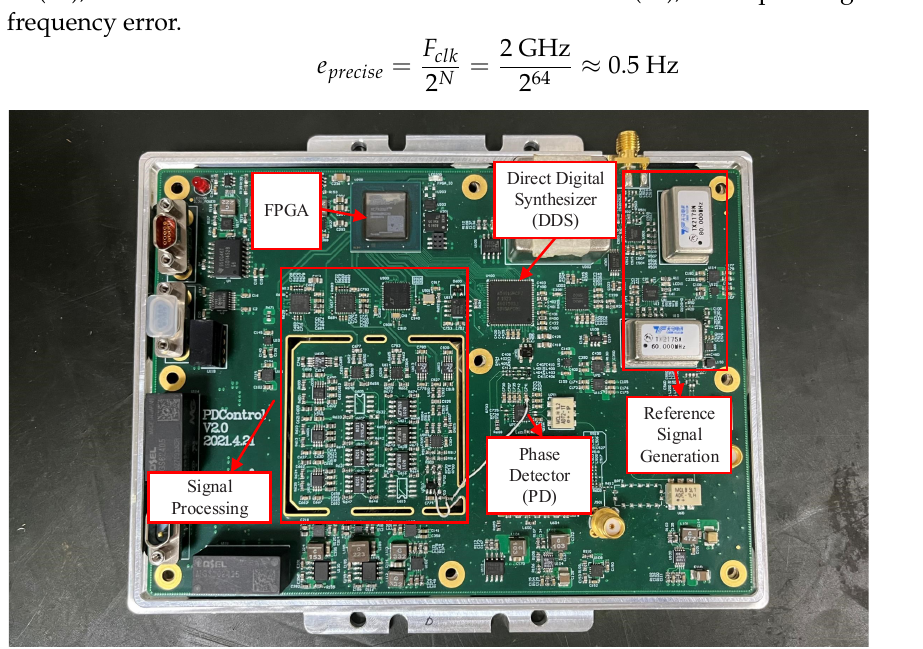
Figure 12. Photograph of the experimental